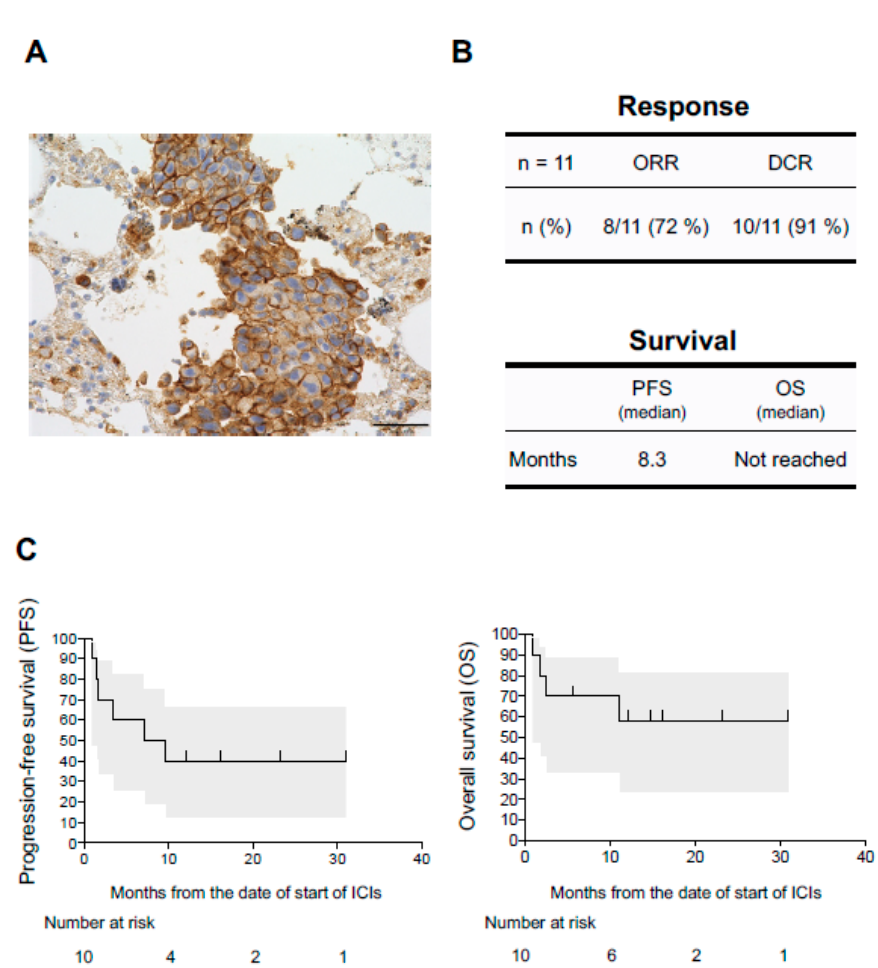
Figure 2. Association between efficacy of ICIs and the diseases associated with disorders of the coagulation-fibrinolysis system triggered by ICIs. ( A ) Representative immunohistochemical staining of the primary lung tumor in case 5, positive staining for programmed cell death-ligand 1 (PD-L1) (clone 22C3 pharmDx kit, tumor promotion score ≥ 75%). Scale bar 50 μ m. ( B ) Upper panel shows objective response rate (ORR) and disease control rate (DCR) in NSCLC patients who developed diseases associated with disorders of the coagulation-fibrinolysis. Lower panel shows median PFS and median OS. ( C ) Kaplan–Meier curves are shown for PFS and OS in those patients. Gray areas indicate 95% confidence intervals of